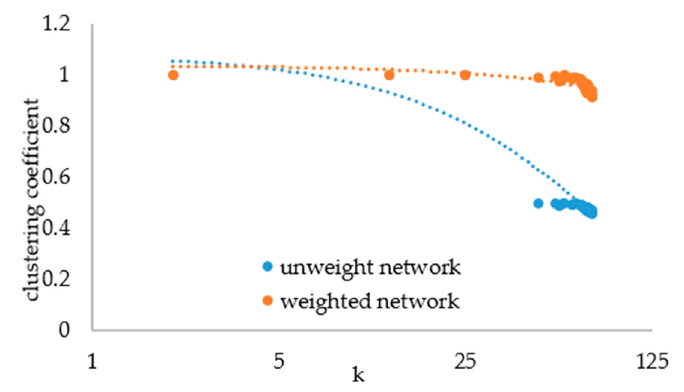
Figure 7. Clustering coefficient changes with node degree.